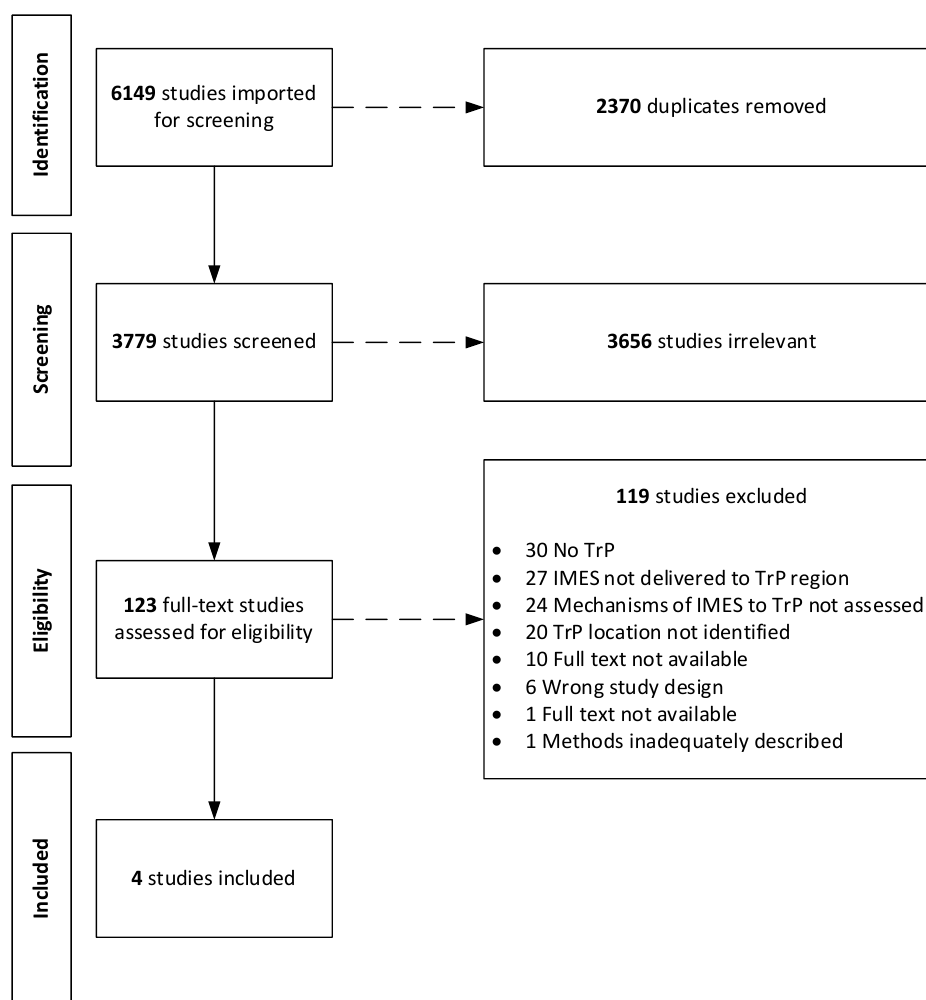
Figure 1. Flow diagram of search process based on Preferred Reporting Items for Systematic Re- views and Meta Analyses Extension for Scoping Reviews (PRISMA-ScR). and Meta Analyses Extension for Scoping Reviews